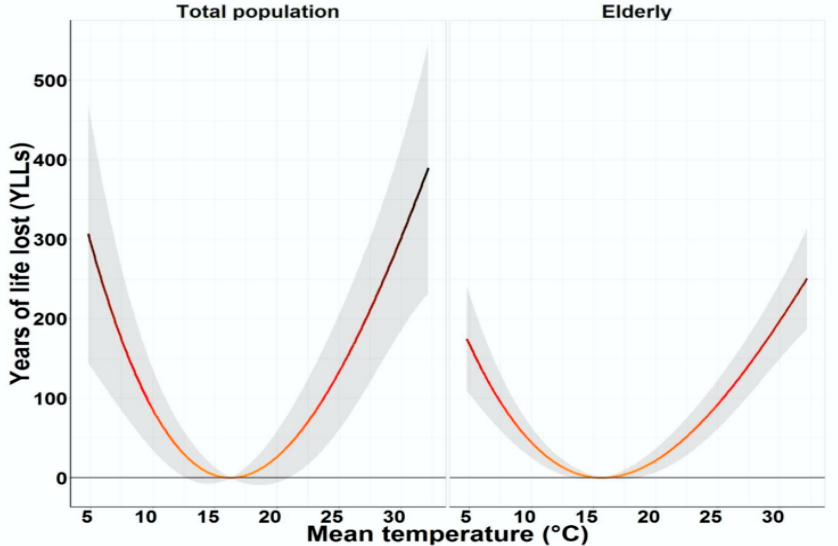
Figure 2. Relationships between daily mean temperature and YLLs in the total population and the elderly. All the effects of temperature on YLLs were adjusted for secular trend, wind speed, day of week, relative humidity, SO 2 , NO 2 , and PM 10 .